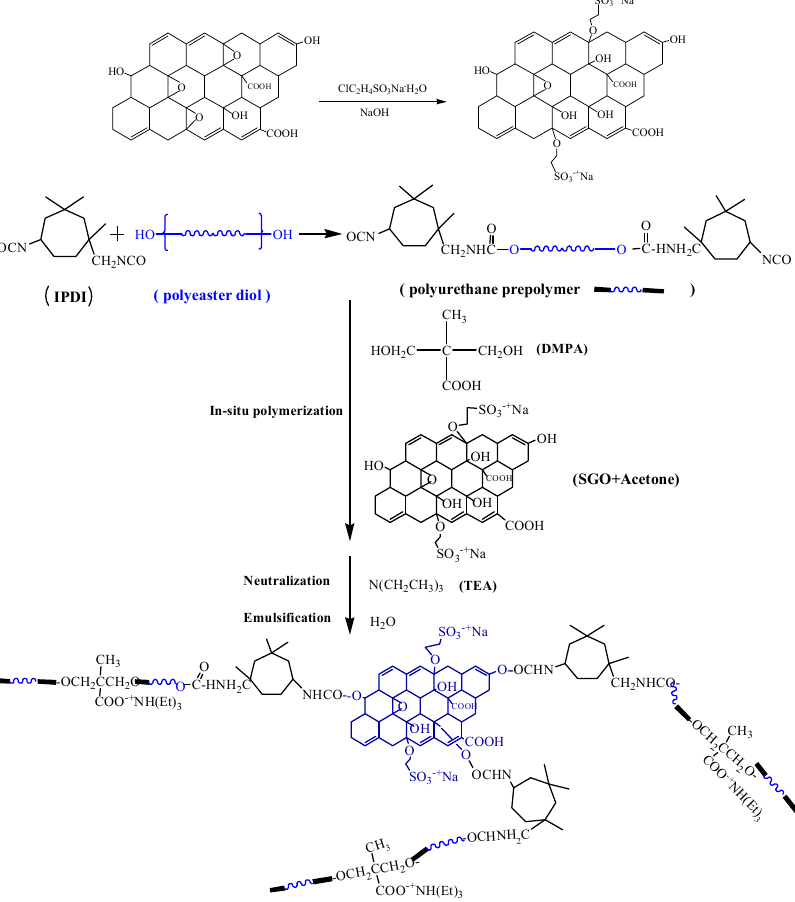
Figure 2. Schematic diagrams of sulfonated modified reaction of GO and synthesis of SGO/WPU.